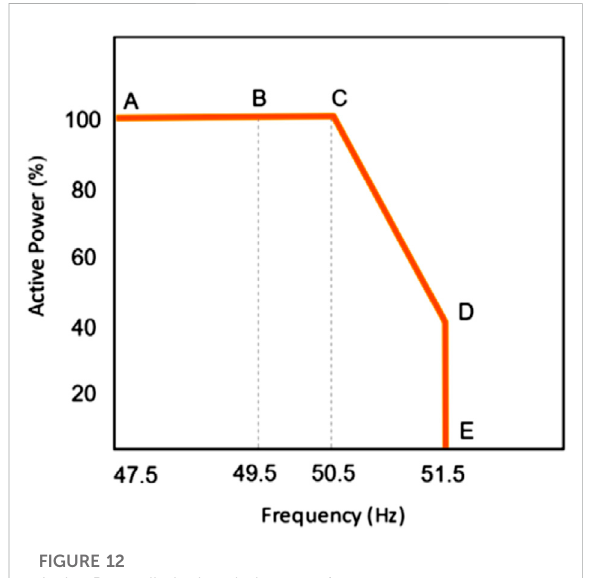
TABLE 2 Cost of modi fi cationsin the